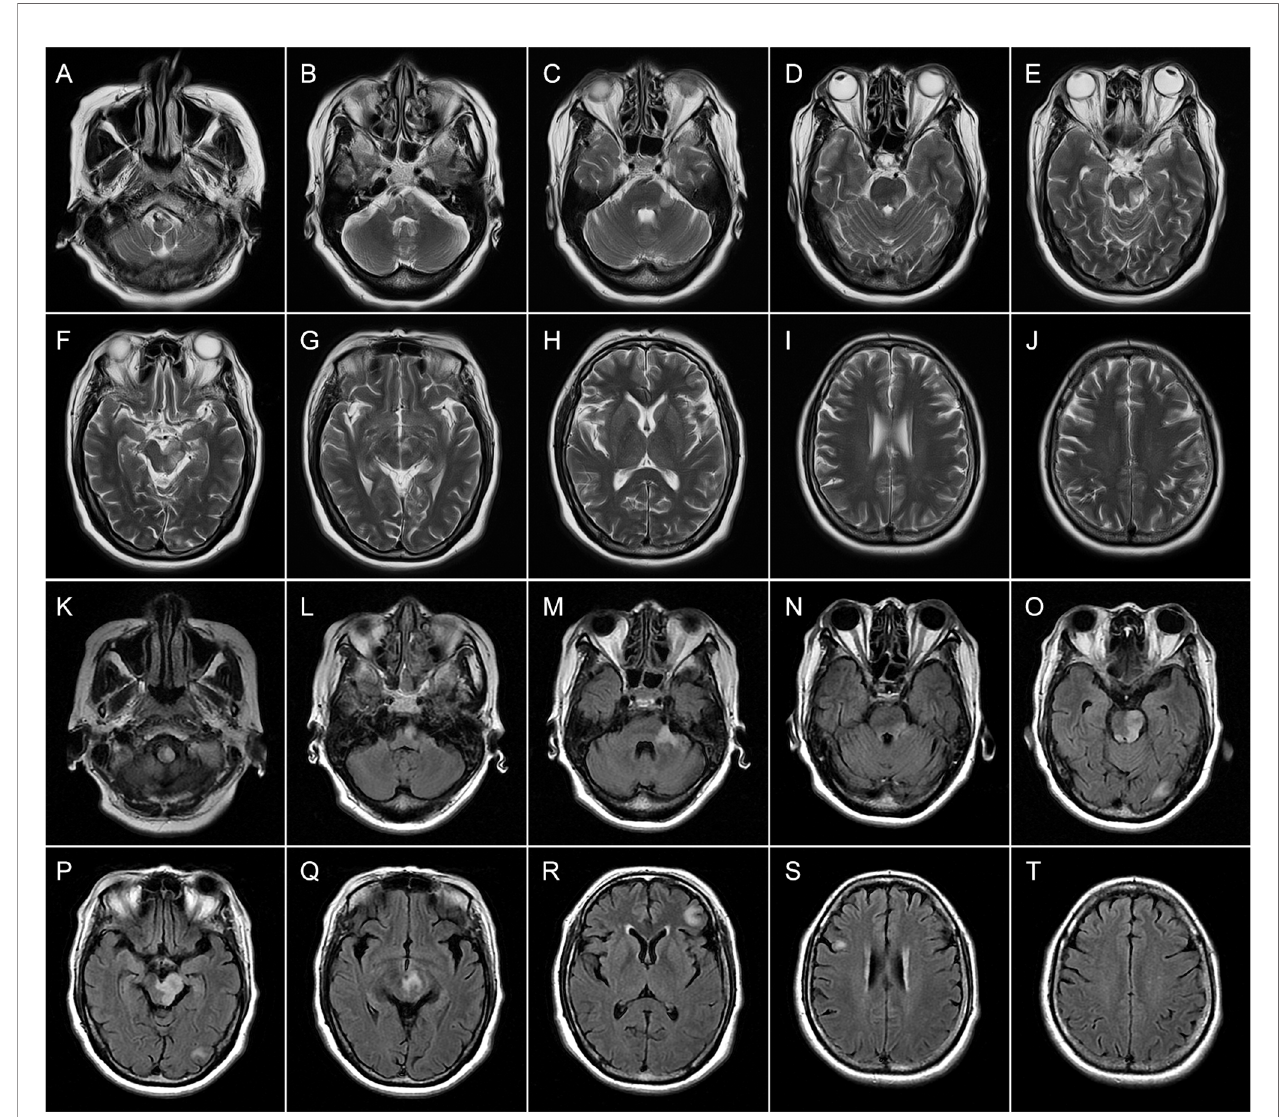
FIGURE 3 | Brain magnetic resonance imaging (MRI) of patient 2 performed during acute attack. Axial T2-weighted (A – J) images obtained 4 days after onset show multiple patchy hyperintense lesions in the left brainstem (medulla, brachium pontis, and midbrain) (A – G) and juxtacortical white matters of the right frontal lobe (I) . Axial FLAIR (K – T) images obtained 15 days after onset reveal expanding lesions in the brainstem (K – Q) . Meanwhile, new patchy or spotty lesions are con fi rmed in the left occipital lobe (O, P) as well as juxtacortical and subcortical white matters of the left frontal lobes (R, T)